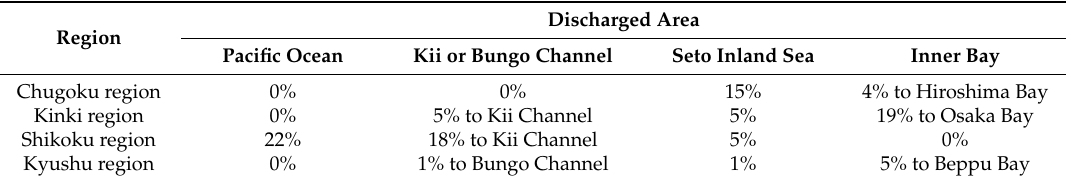
Table 1. Sediment yield of each region and discharge to adjacent marine